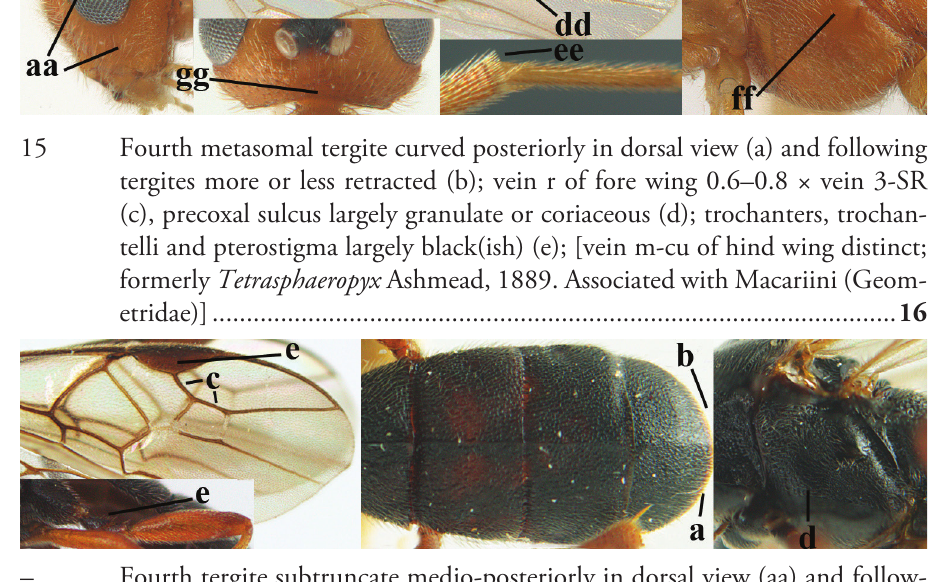
Fourth tergite subtruncate medio-posteriorly in dorsal view (aa) and follow-